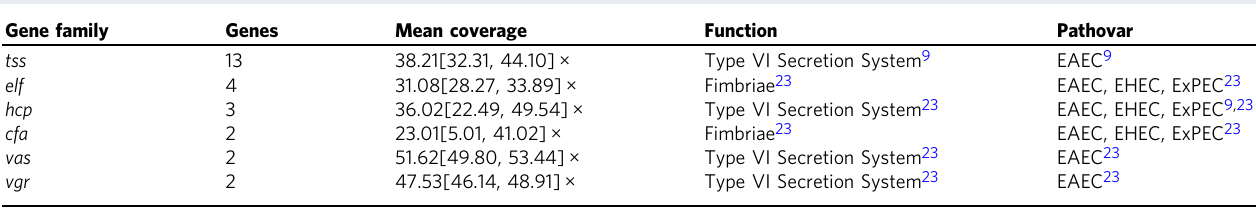
Table 3 Identi fi ed virulence factors which contained genes not found in K-12 MG1655. Gene family